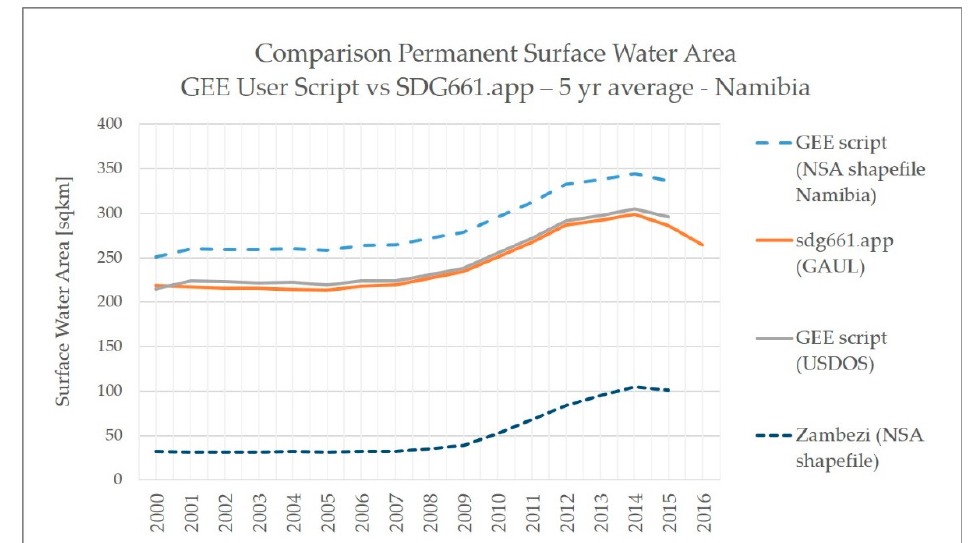
Figure 1. Comparison GSW 5-year average for Namibia with different shapefiles.